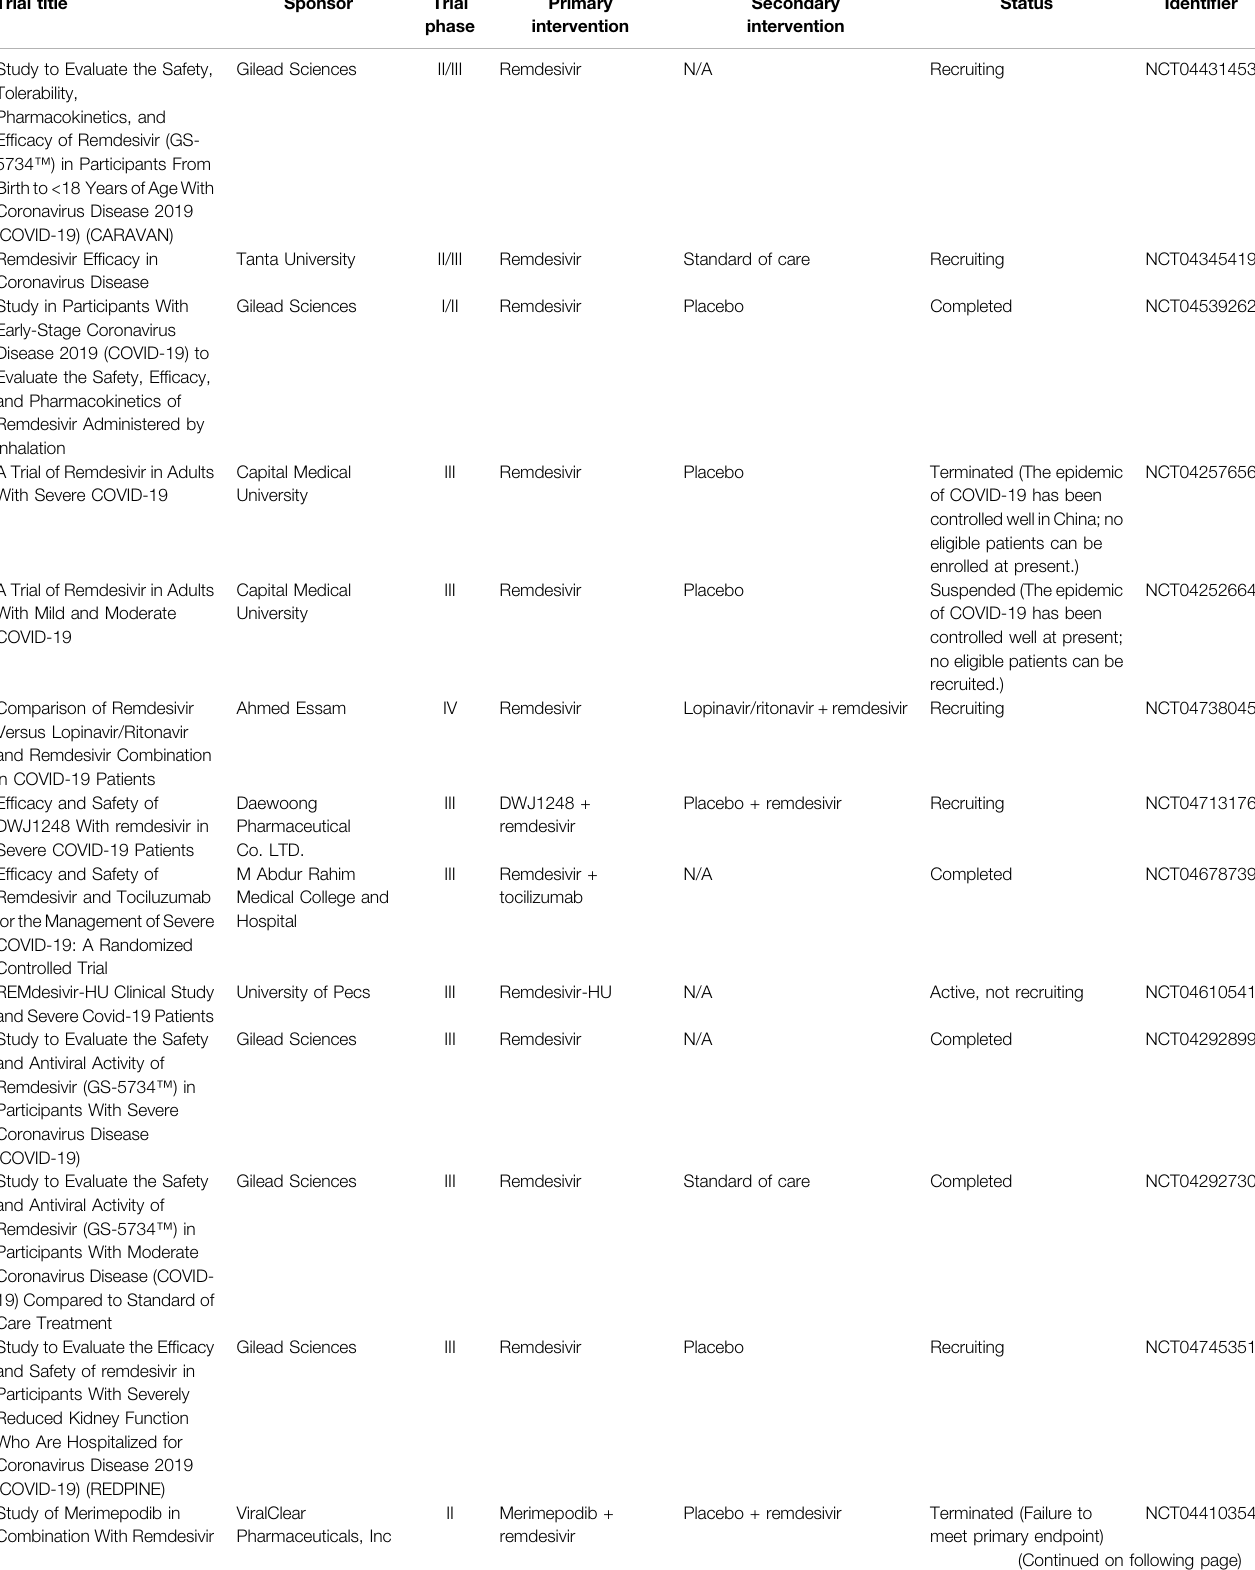
TABLE 3 | Summary of clinical trials of remdesivir on COVID-19